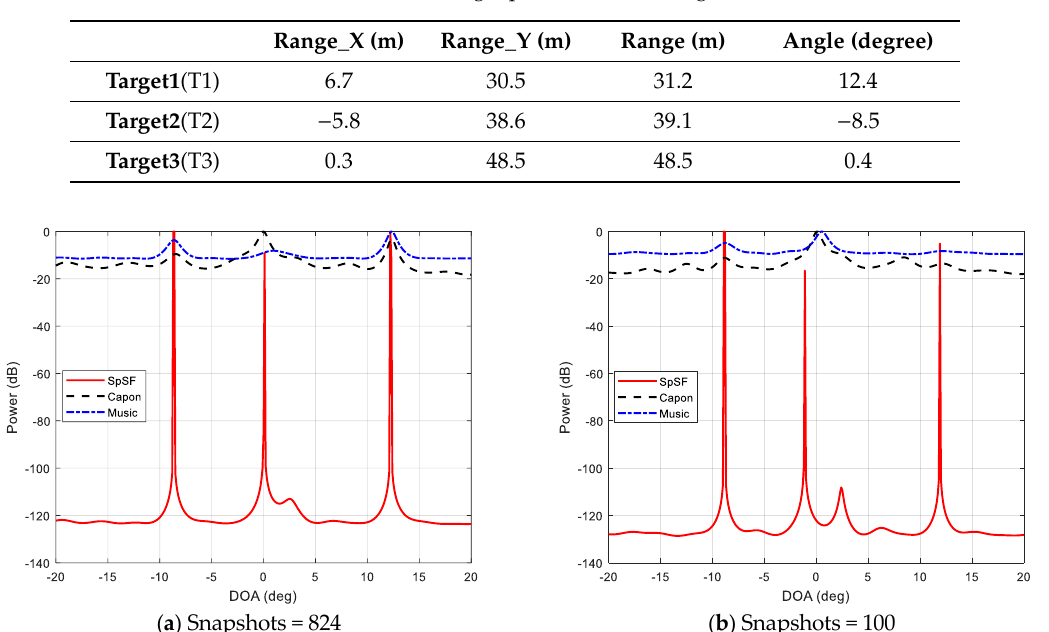
Figure 11. Angle estimation of the real data.